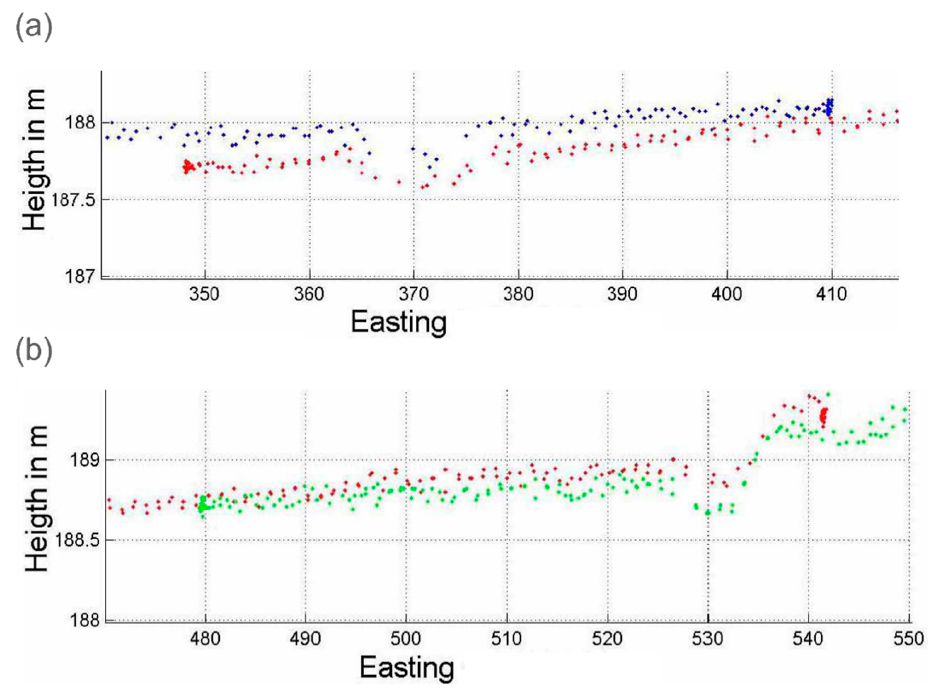
Figure 3. Profile of the overlap area (2 m width) between ( a ) strip 1 and 2, ( b ) strip 2 and 3.